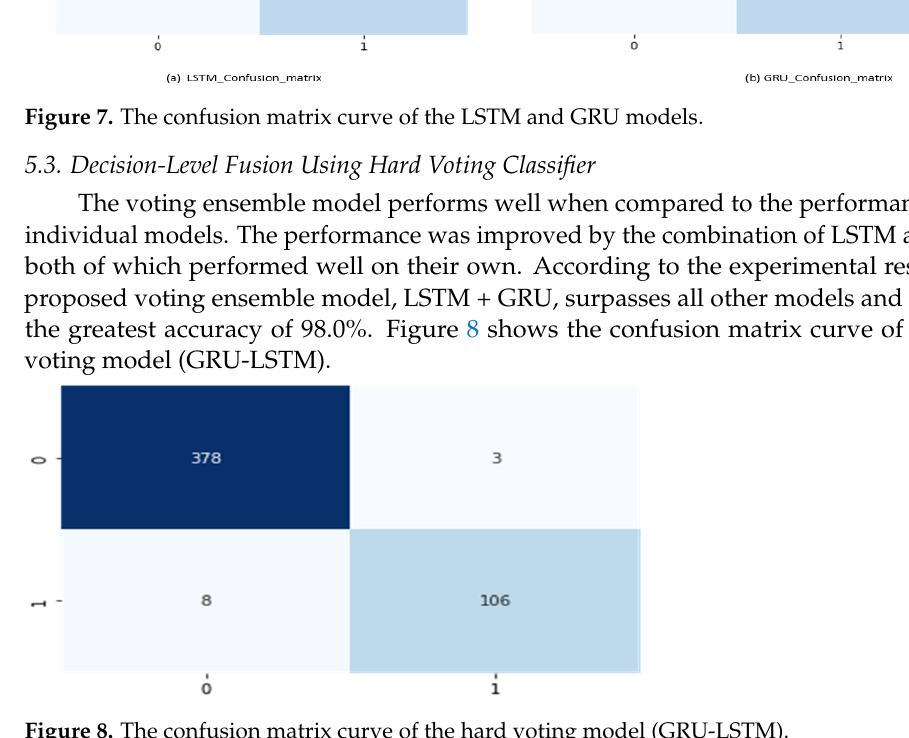
Figure 7. The confusion matrix curve of the LSTM and GRU models.